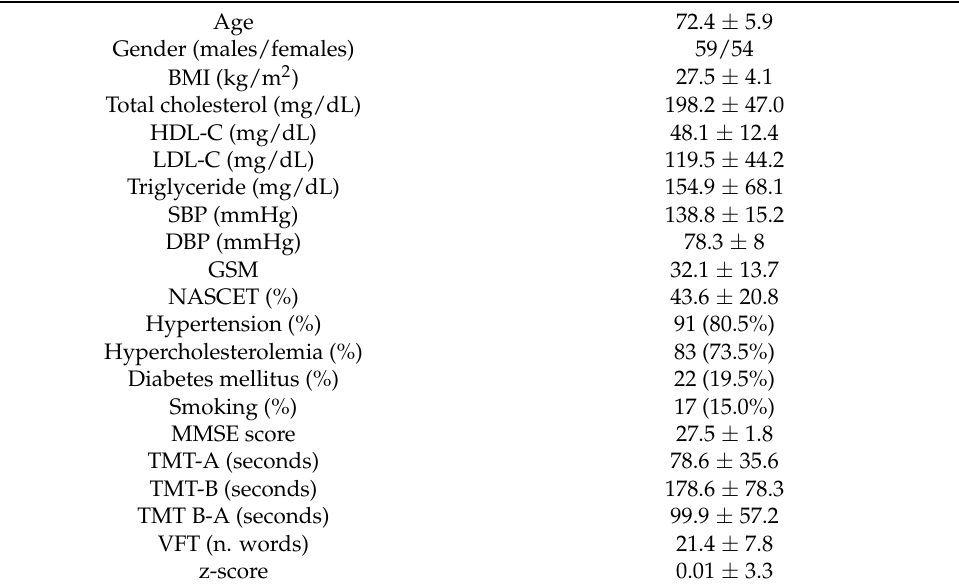
Table 1. General characteristics of the study population at